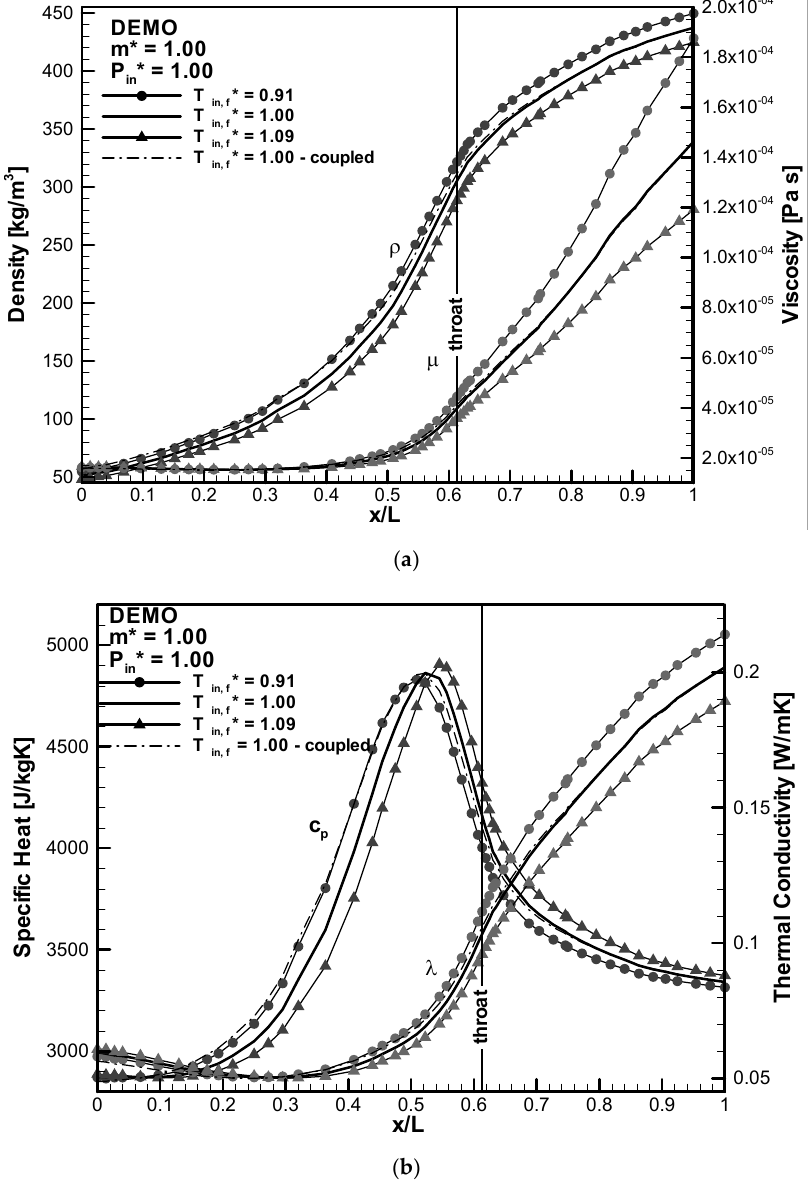
Figure 14. Axial profiles of thermophysical properties, considering different values of inlet fluid temperature (runs 1-4): ( a ) density and viscosity; ( b ) specific heat and thermal conductivity. Figure 15 depicts the dimensionless temperature fields, considering the nominal working conditions, and some transversal slices of interest are highlighted. In particular, seven significant sections are chosen, and their position corresponds to the outlet ( x/L = 0.00), reattachment point region ( x/L = 0.13), a section where the pseudocritical conditions inside the channel are observed on average ( x/L = 0.52), the throat one ( x/L = 0.61), a section